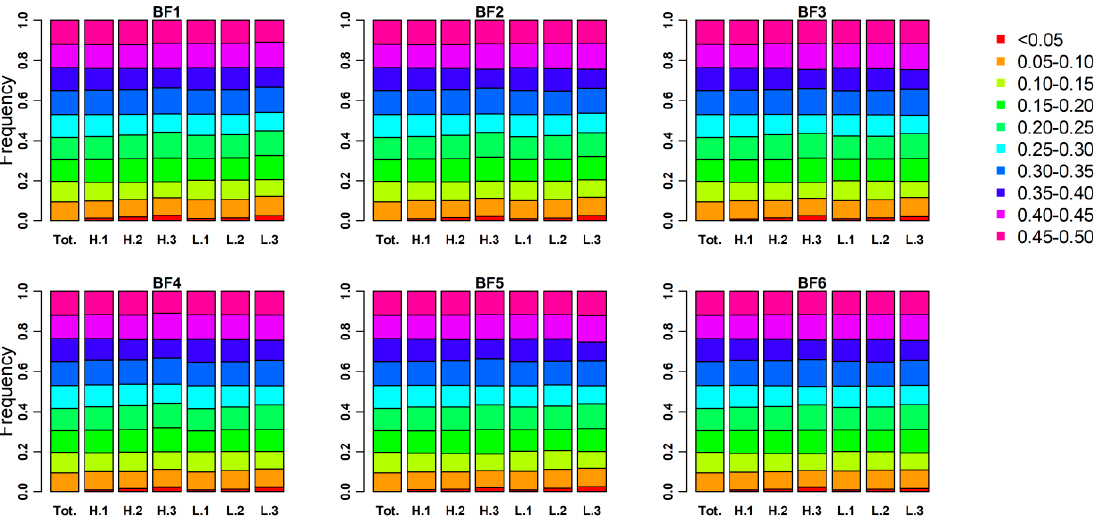
Figure 2. The distributions of minor allele frequency in each subpopulation for backfat thickness traits. Rectangles of different colors indicate different clusters of MAF (minor allele frequency), while rectangles of different lengths indicate the proportions of markers within different clusters. Tot. represents the source Yorkshire population, H.1 (H.2, H.3) and L.1 (L.2, L.3) represent the two subpopulations of 1st (2nd and 3rd) population pair.